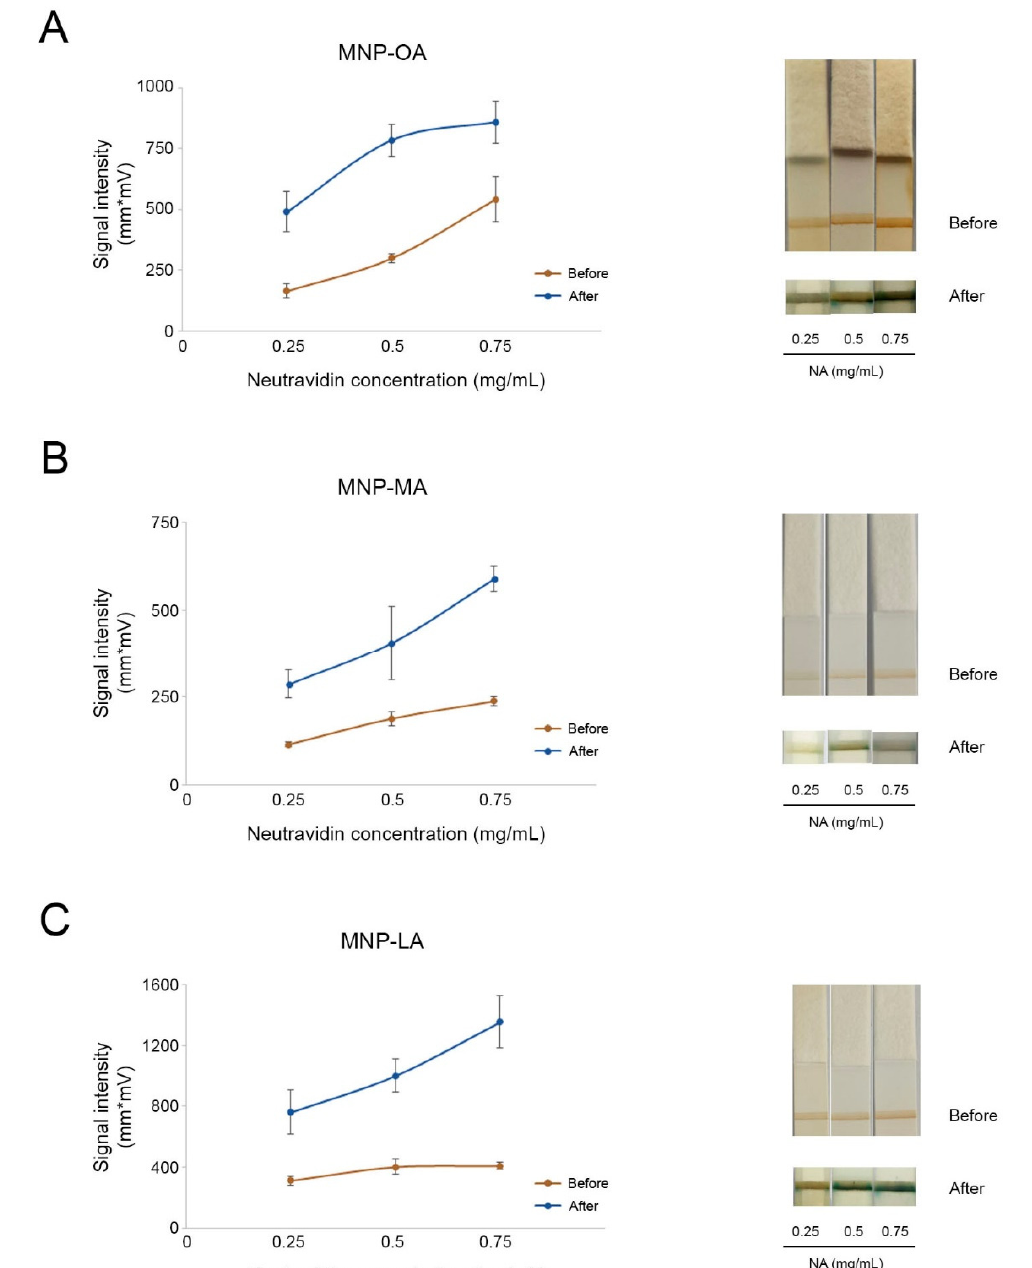
Figure 3. Nanozyme-mediated signal enhancement on lateral flow strips. MNP-OA ( A ), MNP-MA ( B ), and MNP-LA ( C ) were functionalized with different concentrations of neutravidin (0.25 mg/mL, 0.5 mg/mL, 0.75 mg/mL) and used as reporter labels for affinity assays. Signal intensities were measured before (brown lines) and after (blue lines) signal enhancement. Graphs show the means ± SDs of three independent experiments. Representative LFA strips before and after enhancement are shown for each concentration.